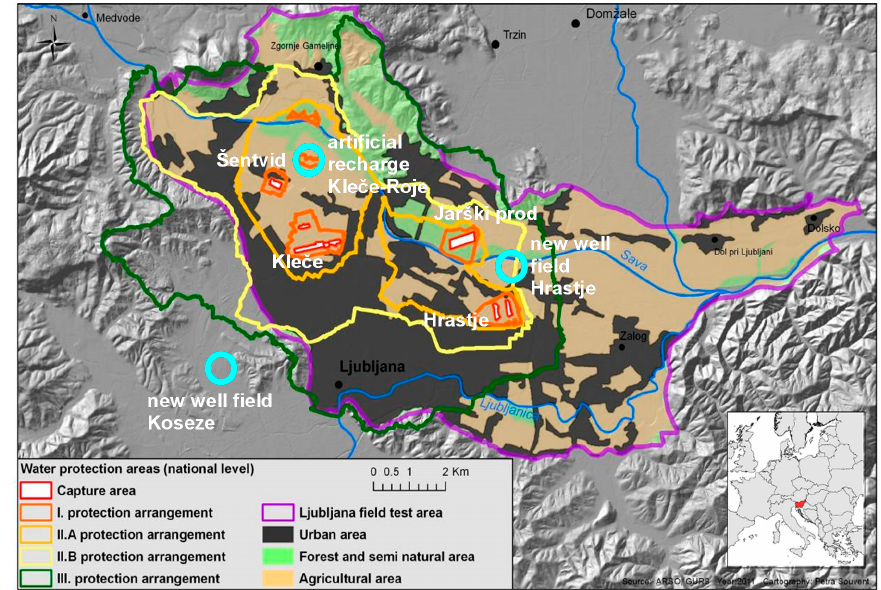
Figure 2. Ljubljana Field aquifer (violet line) with the main land-uses (urban, forest, and agricultural areas), existing water well fields (white areas, lined with red), water protection zones (I–III) and alternative management actions (blue